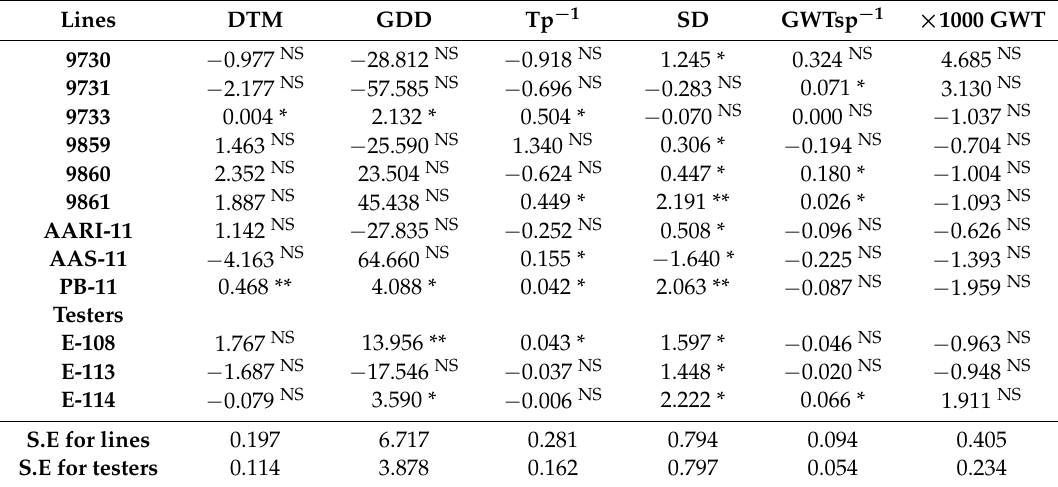
Table 2. General combining ability (GCA) effects of parents.